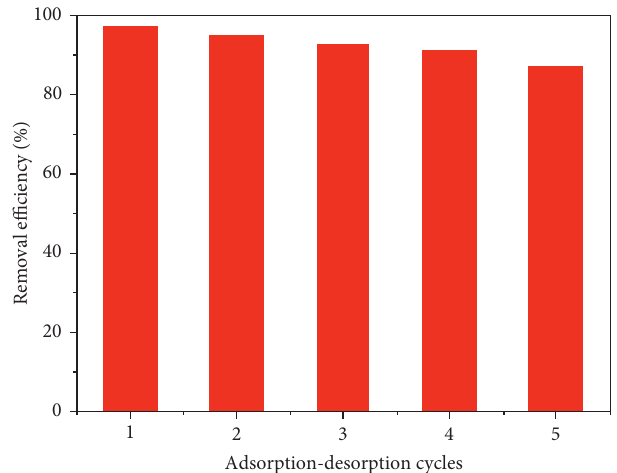
Figure 12: The Co(II) removal efficiency of the GTNTcomposites after 5 adsorption-desorption cycles.